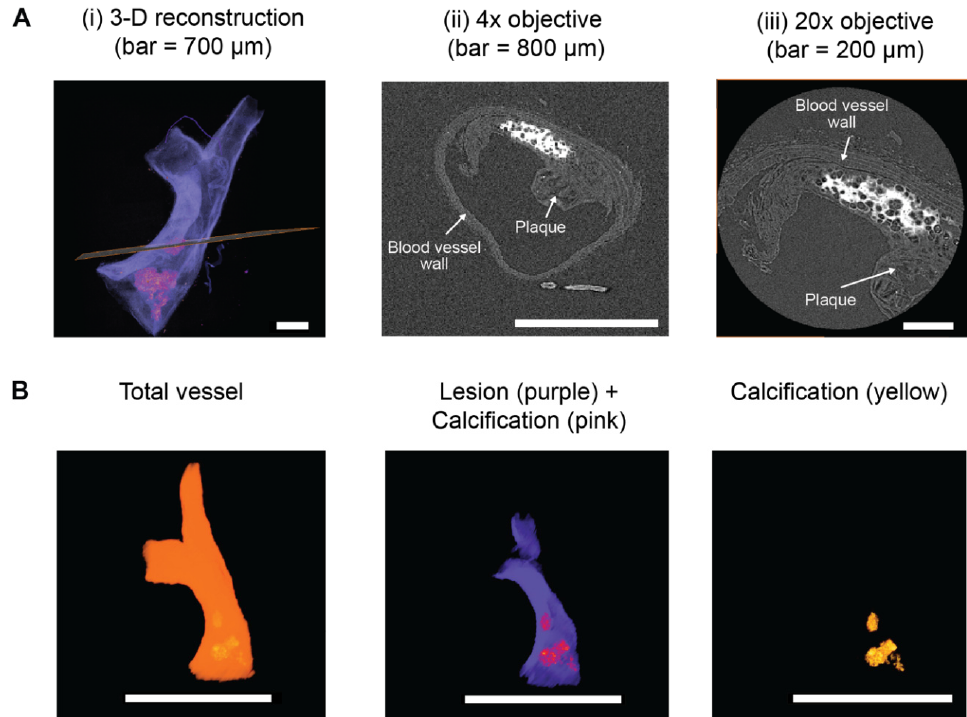
Figure 5. 3-D µCT segmentation of calcified blood vessels. A brachiocephalic artery from a 10-week old ApoE -/- mouse fed a high fat, high cholesterol diet for 28 weeks was scanned by µCT using a voxel size of 3 µm, and the images were reconstructed to form a 3-D imaged volume ( A )/( i ). A phase virtual slice from the 3-D imaged volume (indicated by the orange line) is shown in part ( A )/( ii ). X-ray dense calcifications (white) are evident within the plaque. ( A )/( iii ) A phase virtual slice from the same region scanned by µCT using a voxel size of 0.5 µm. ( B ) As there is low absorption contrast between the blood vessel wall and plaques, thresholding methods cannot be applied to segment these two volumes. Therefore, scans were manually segmented into the total blood vessels and plaque volumes. Thresholding was applied to segment the X-ray dense calcifications from the plaque. Scale bar = 2000 µ